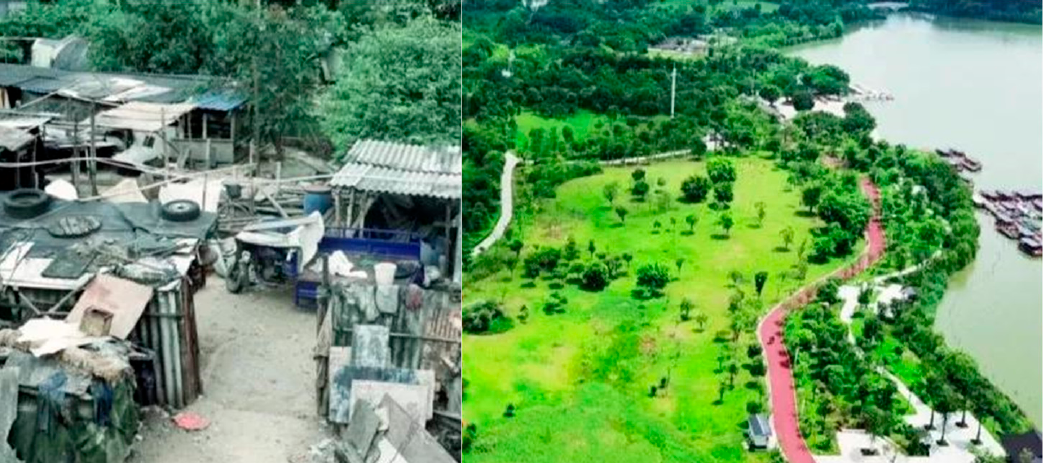
Figure 5. Landscape before and after ELR in Huayang Lake National Wetland Park. Note: In the process of ELR, the government guided the withdrawal of approximately 1,333,333 m 2 of industrial land in the surrounding area; demolished 223 livestock farms totaling 165,000 m 2 , and promoted the expansion of ecological land and the improvement of recreational